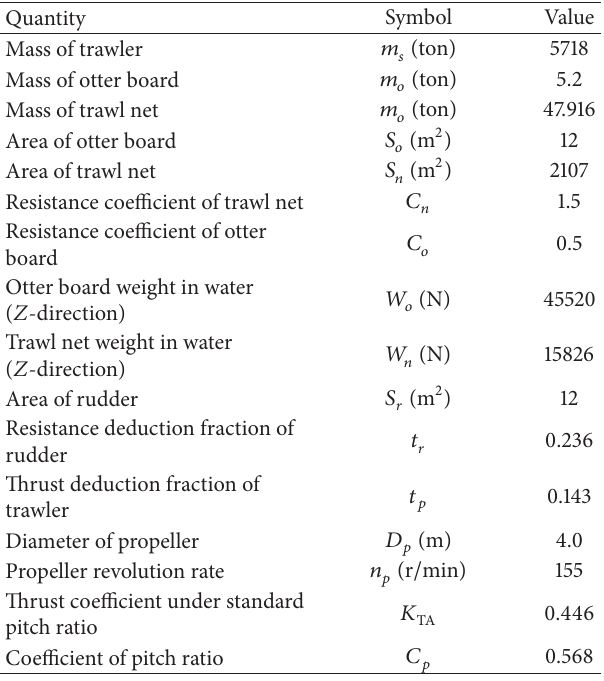
Table 1: Trawler, otter board, and trawl net parameters.